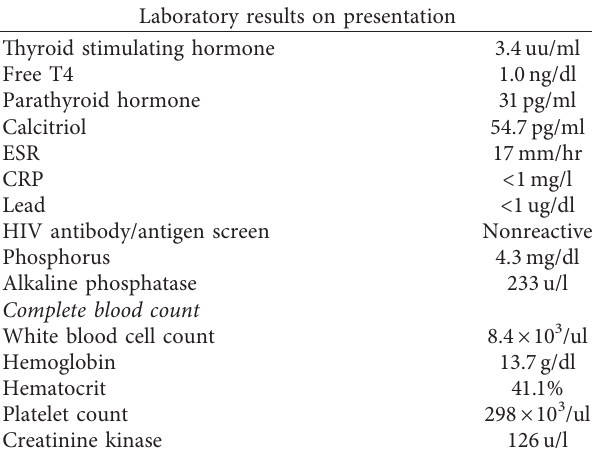
Table 1: Laboratory analysis.